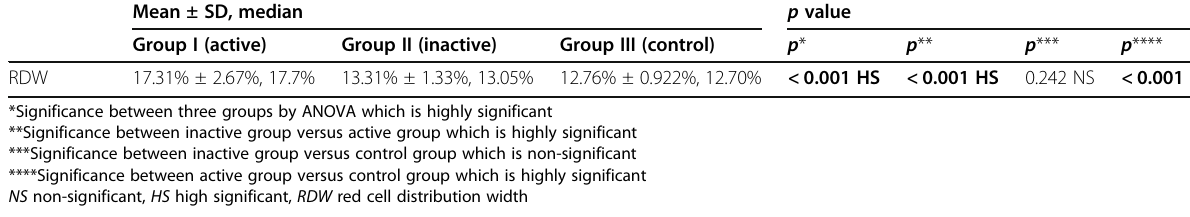
Table 4 Comparison between the three groups as regard RDW%